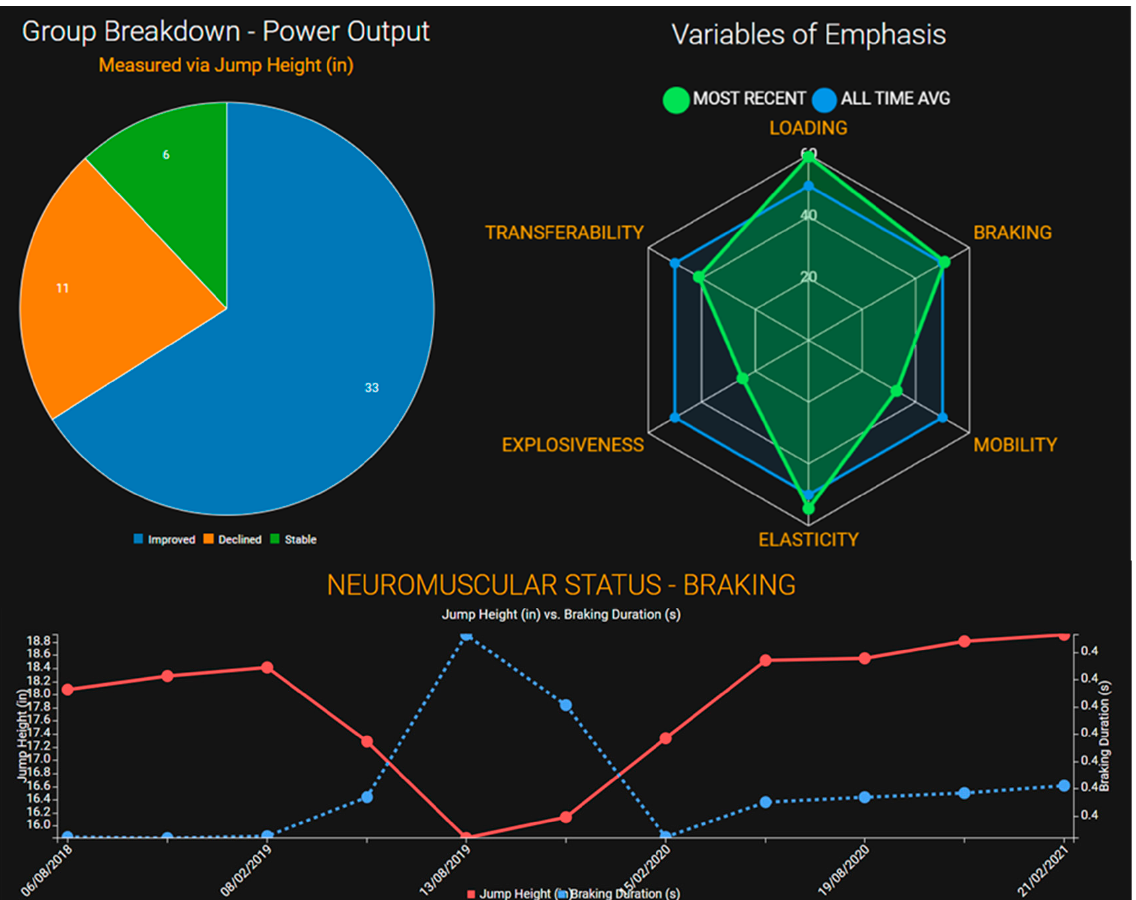
Figure 4. Examples of assessing group responses through the number of individuals that improved, declined, or remained stable and group/individual changes of important domains in comparison to historical averages using Z-scores. Neuromuscular status-braking plots synthetic data to display the relationship between jump height (red) and braking phase duration (blue dots).